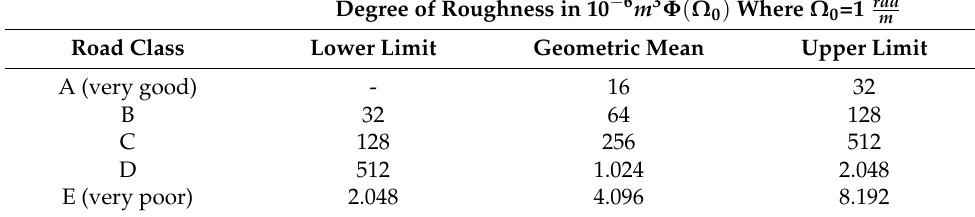
Table 6. The ISO classification of road